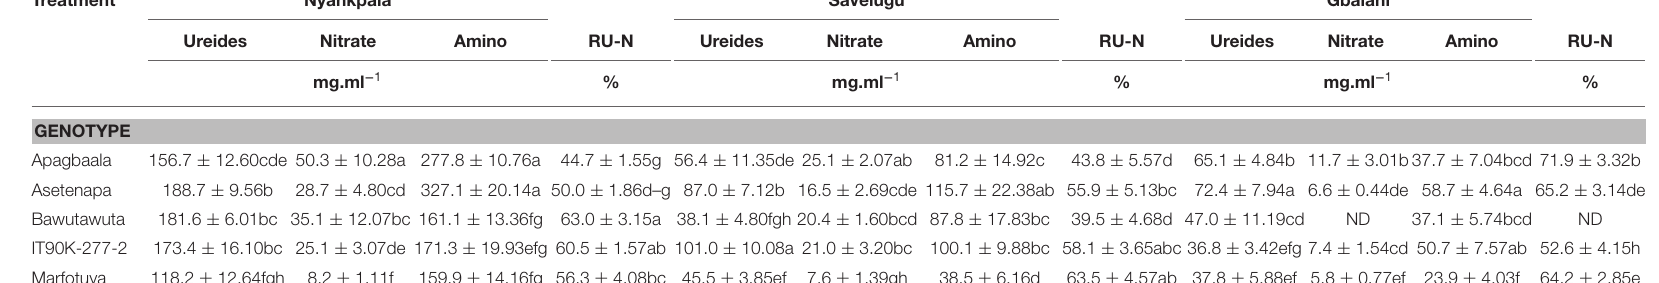
TABLE 5 | The concentrations of ureides, nitrate, amino-N, and Relative ureide-N in xylem sap of cowpea genotypes inoculated with two Bradyrhizobium strains and planted in Nyankpala, Savelugu and Gbalahi in 2013.